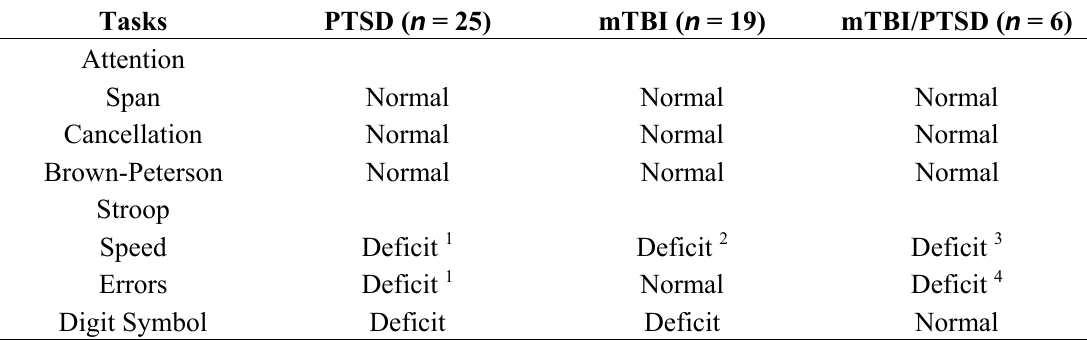
Table 2. Summary of Clinical Group Results on all Neuropsychological